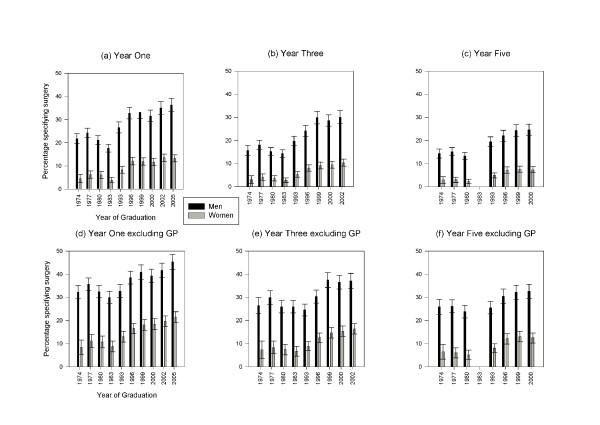
UK Doctors who specified surgical specialties as their first choice of eventual career*. Footnotes: Percentages (with 95% confidence intervals) in each year after graduation, first choices for surgery including tied first choices, showing (a to c) percentages of all respondents, and (d to f) percentages of all respondents excluding those who specified general practice as their first choice. Figures 1a-1c: Numbers of respondents: 14 345 (men), 13 404 (women), 27 749 (total) in Year One; 12 420 (men), 11 048 (women), 23 468 (total) in Year Three; 9 561(men), 8 128 (women), 17 689 (total) in Year Five. Chi square tests (χ21) comparing first choice for surgical specialties made by men and women (all graduation years combined): Year One 1293.7; Year Three 919.7; Year Five 658.5; all years P <0.001. Figures 1d-1f: Numbers of respondents excluding those with first choices for GP: 10 567 (men), 8 331 (women), 18 898 (total) in Year One; 8 569 (men), 6 441 (women), 15 010 (total) in Year Three; 6 307 (men), 4 557 (women), 10 864 (total) in Year Five. Chi square tests (χ21) comparing first choice for surgical specialties made by men and women (all graduation years combined) excluding GP: Year One 968.5; Year Three 706.8; Year Five 523.6; all years P <0.001.